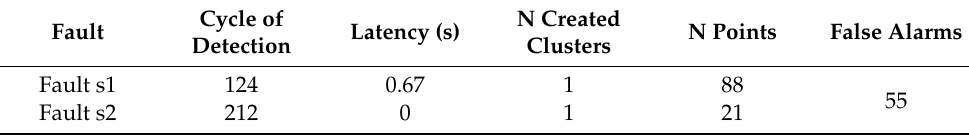
Table 6. Performances of the clustering-based from scratch approach (suction